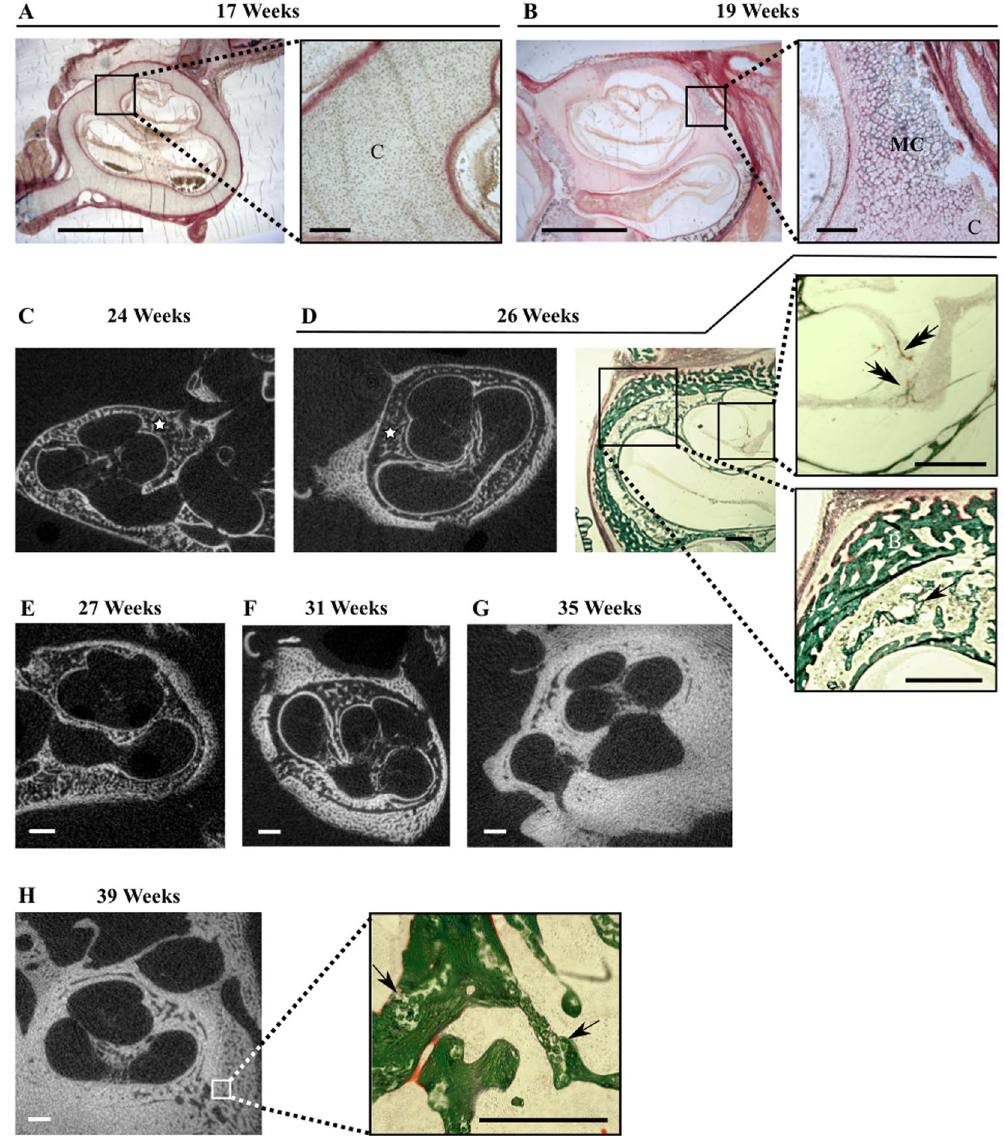
Figure 4. Ossification of the cochlear otic capsule. Goldner stained ( A , B and D ) and/or μ CT sections ( C – H ) of the cochlea between 17 and 39 weeks of gestation. In A: C = Cartilage, MC = Mineralized Cartilage, Stars in C and D: Trabecular area (“Middle Layer”), Simple arrows in D and H: Cartilage remains (clear areas), Double arrow in D: Membranous modiolar bone profiles. Bars = 1.0 mm, exc3ept for insets in A and B: 100 μ